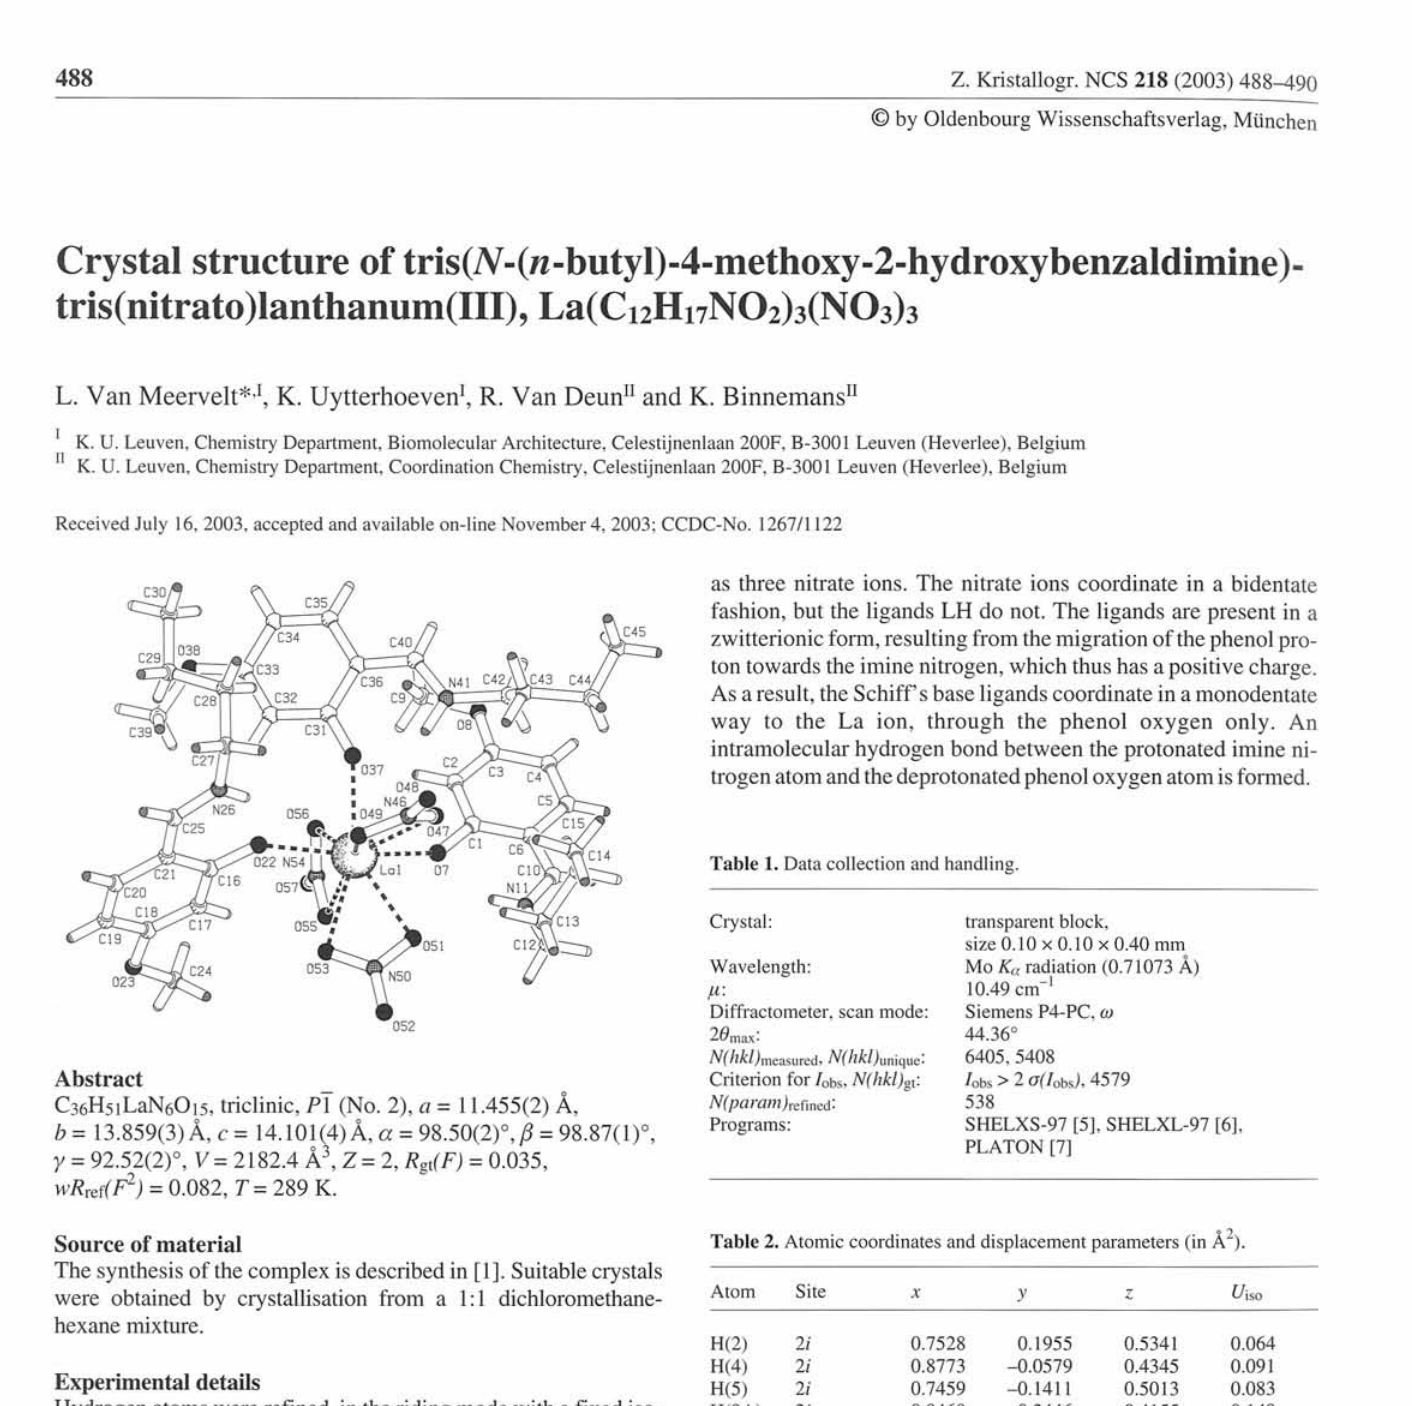
Table 2. Atomic coordinates and displacement parameters (in Â 2